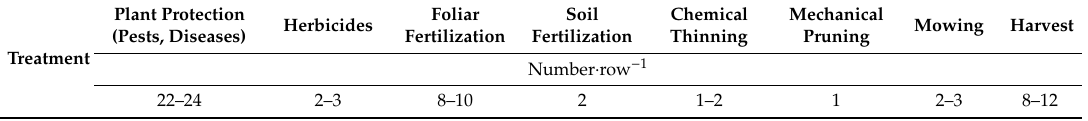
Table 2. Number of agrotechnical and chemical treatments in apple